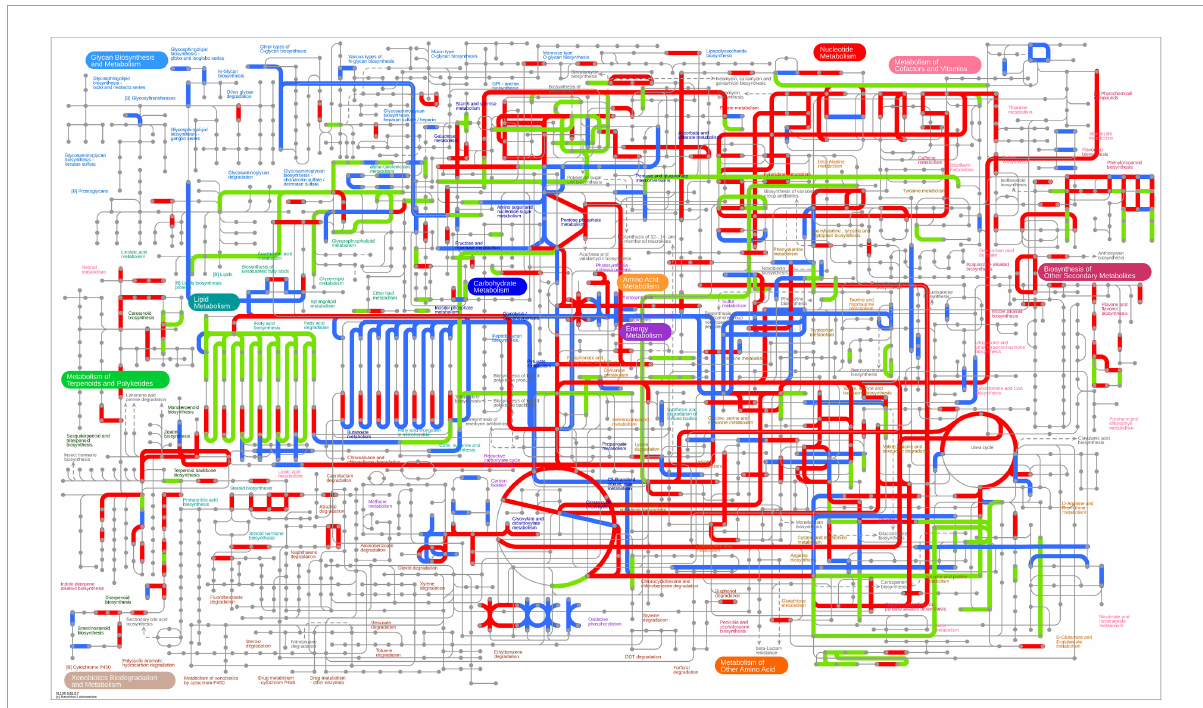
FIGURE9 Distribution of DEGs on iPath integration metabolic pathway in paired comparison of Gm-Ba-Ss vs. Gm. The red line represents the pathway affected by up-regulated genes, the blue line represents the pathway affected by down-regulated genes, and the yellow line represents the pathway affected by both up-regulated and down-regulated